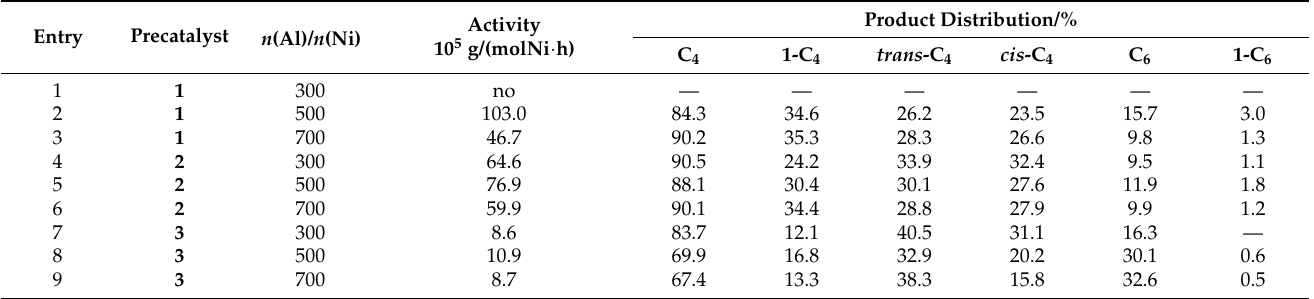
Table 4. Effects of n (Al)/ n (Ni) ratio for precatalysts 1 – 3 on ethylene oligomerization a .